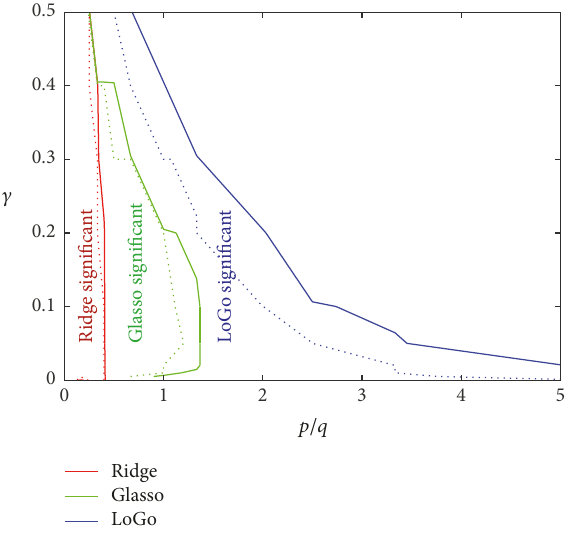
Figure 1: Regions in the 𝑝/𝑞 - 𝛾 space where causality networks for the three models are statistically significant . The significance regions are all at the left of the corresponding lines. Tick line reports the boundary 𝑃 < 0.05 (see (6)) and dotted lines indicate 𝑃 < 10 −8 significance levels ( 𝑃 is averaged over 100 processes). The plots refer to 𝑝 = 100 and report the region where the causality networks are all significant for 100 processes.